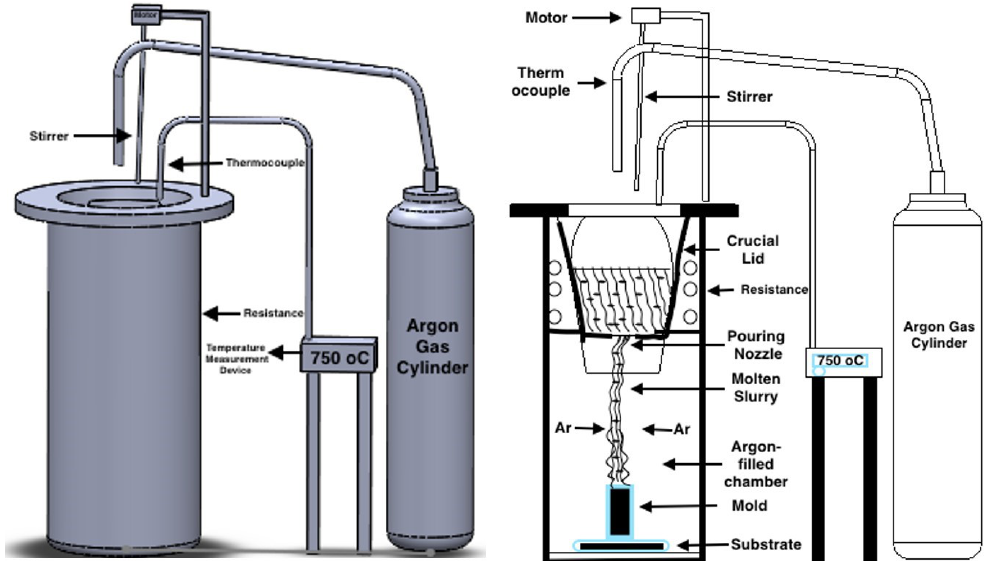
Figure 1. Experimental setup of the DMD method.